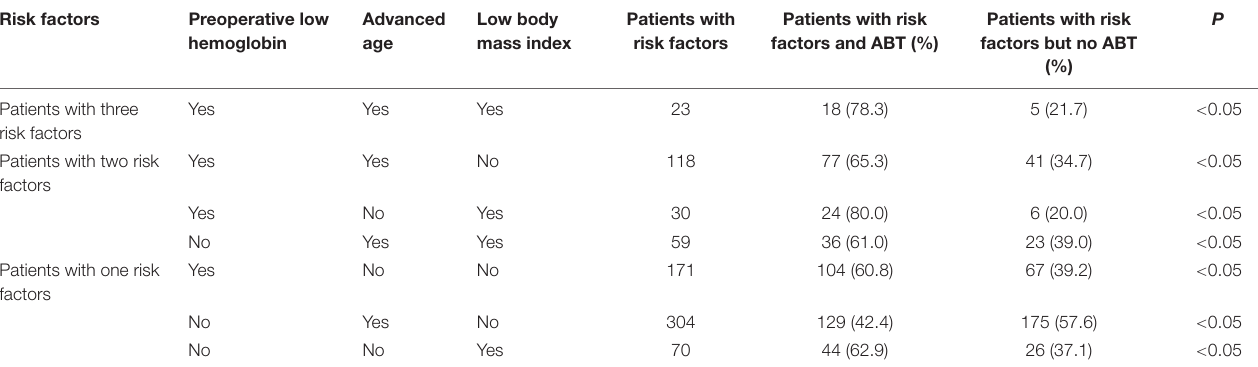
TABLE 3 | The multivariate